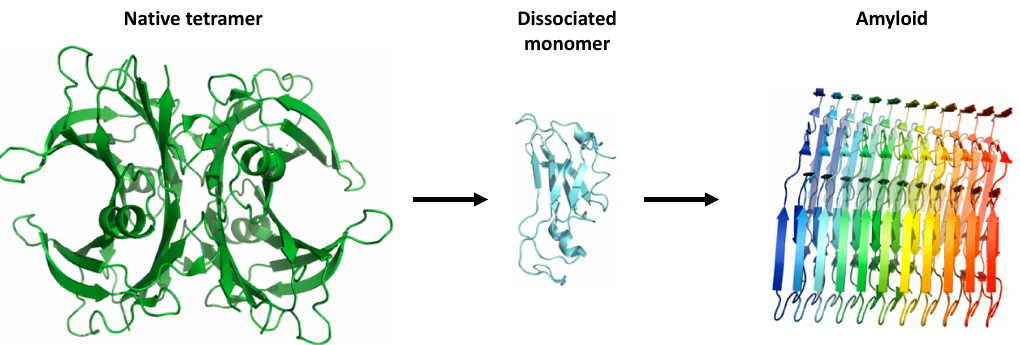
Figure 2. The proposed aggregation mechanism of transthyretin (TTR). The native tetrameric state of TTR [PDB 4tlt] is stable and physiologically active, while dissociation of non-native monomeric species [PDB 2nbo] initiates the pathogenic aggregation pathway of TTR. This results in accumulation of amyloid fibrils [PDB 6sdz].